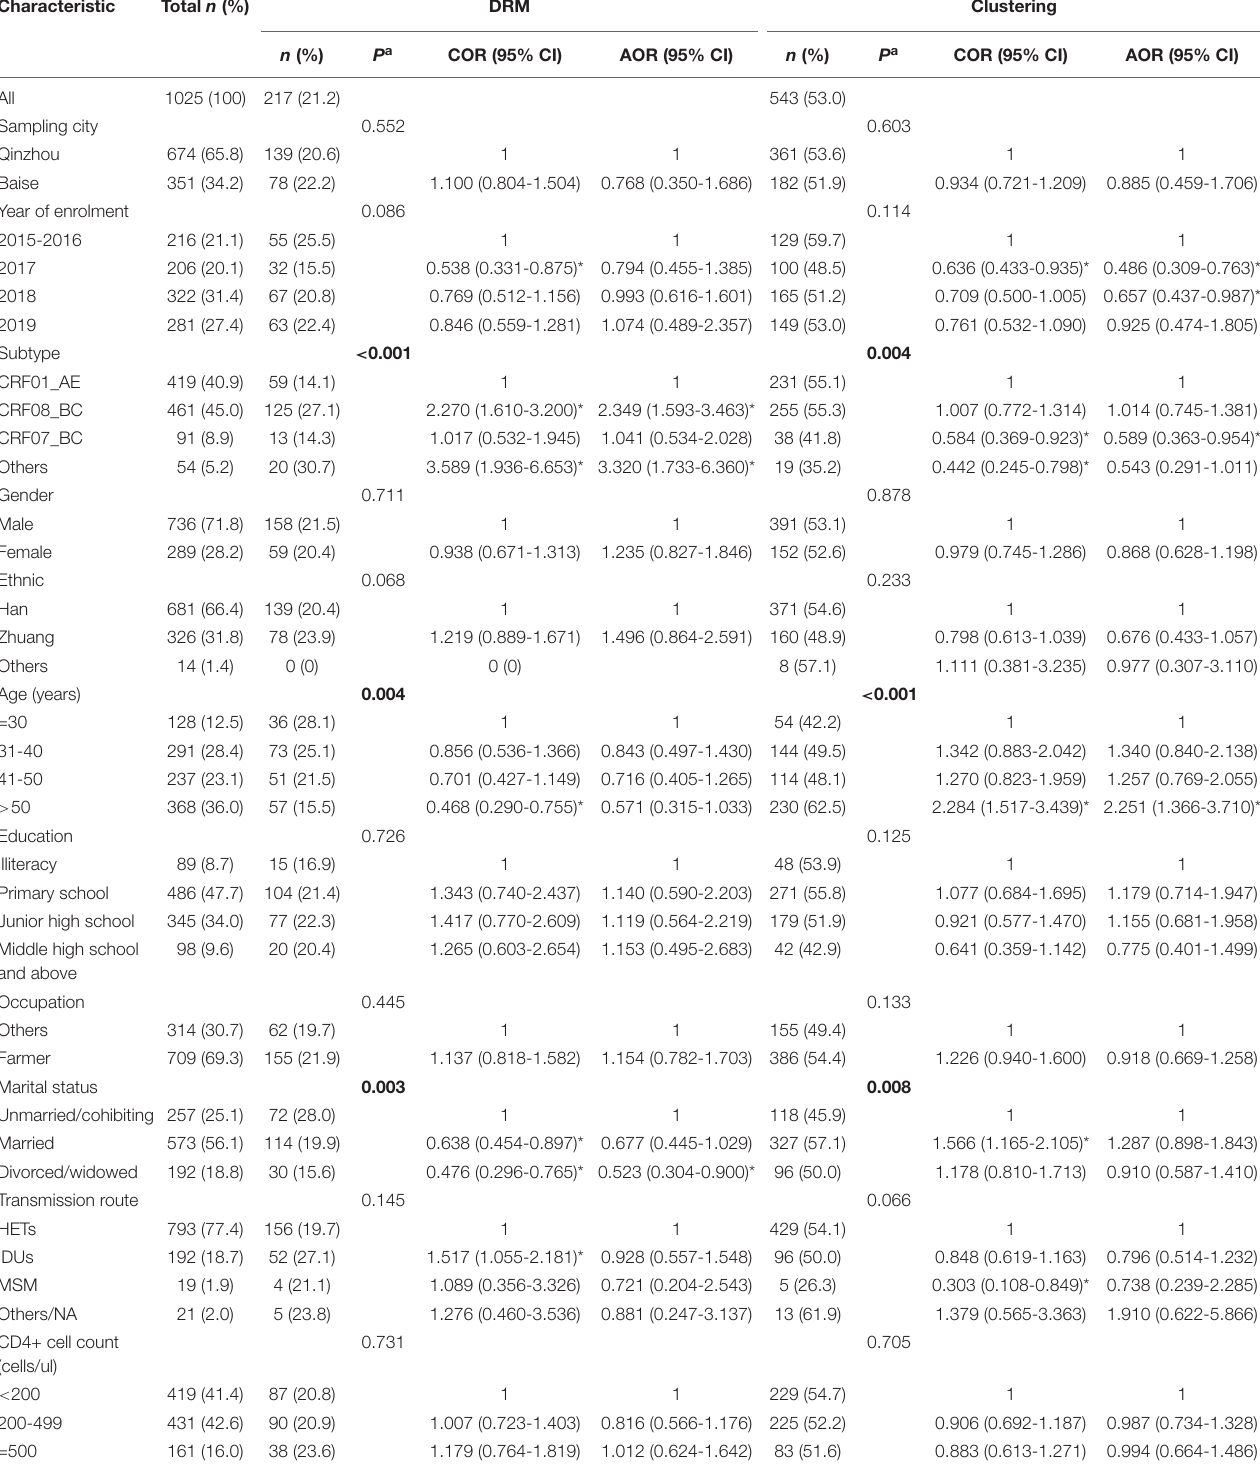
TABLE 1 | Factors associated with drug resistance mutation (DRM) and clustering among HIV-1 infected and ART-naïve individuals in Guangxi, 2015–2019.